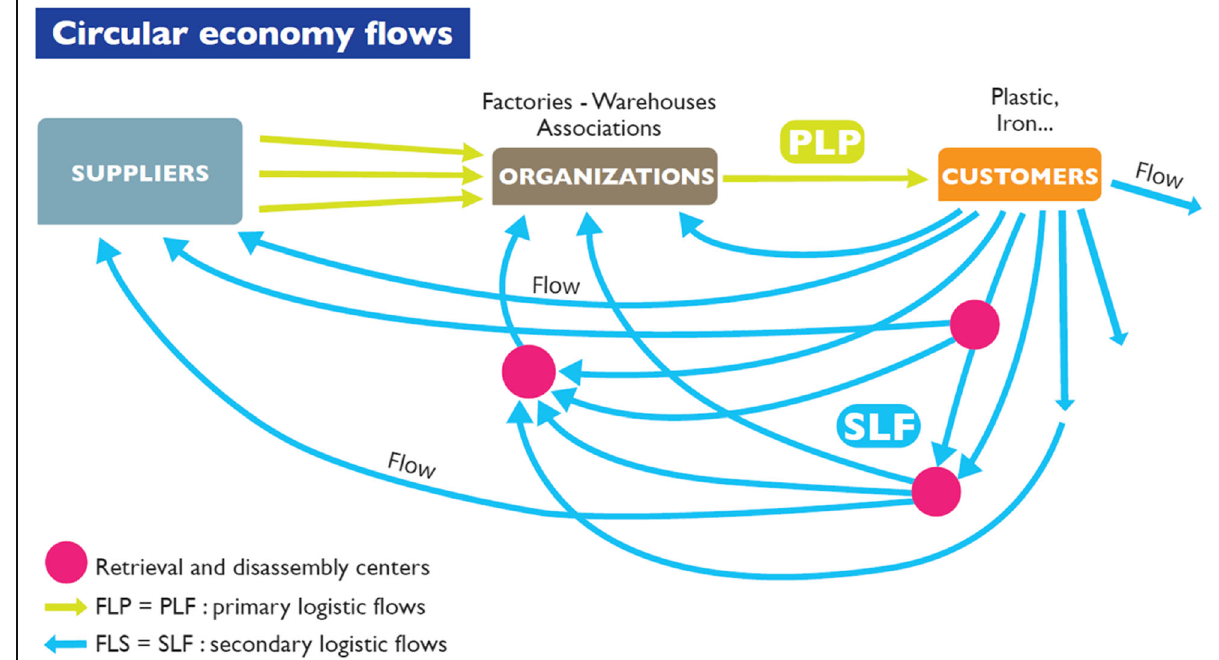
Fig. 2 Example of flows in a circular